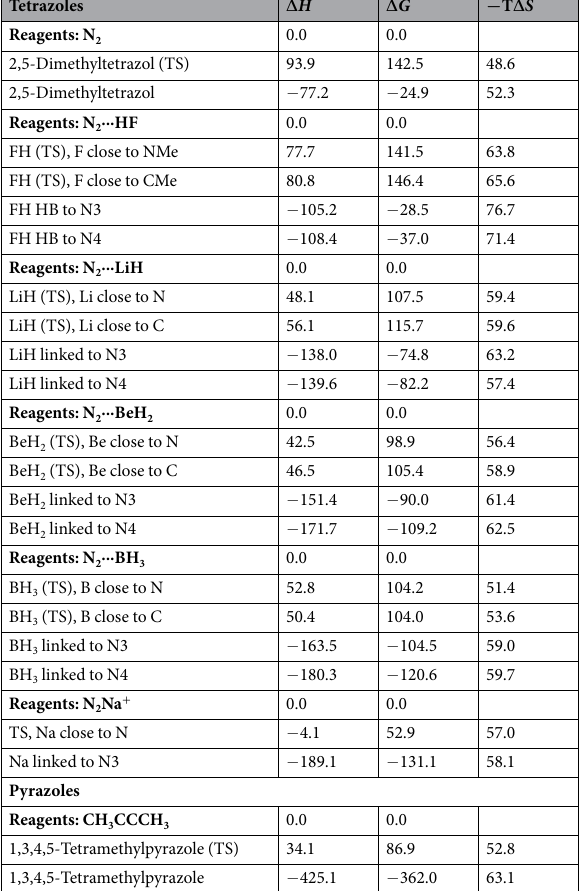
Table 1. Enthalpy, free energy and entropy contributions (kJ·mol –1 ) for the 1,3-dipolar cycloaddition between dimethyl nitrile imine and different dipolarophiles at the G4MP2 level (T = 298.15 K). Dimethyl nitrile imine is omitted as a reagent for the sake of clarity.